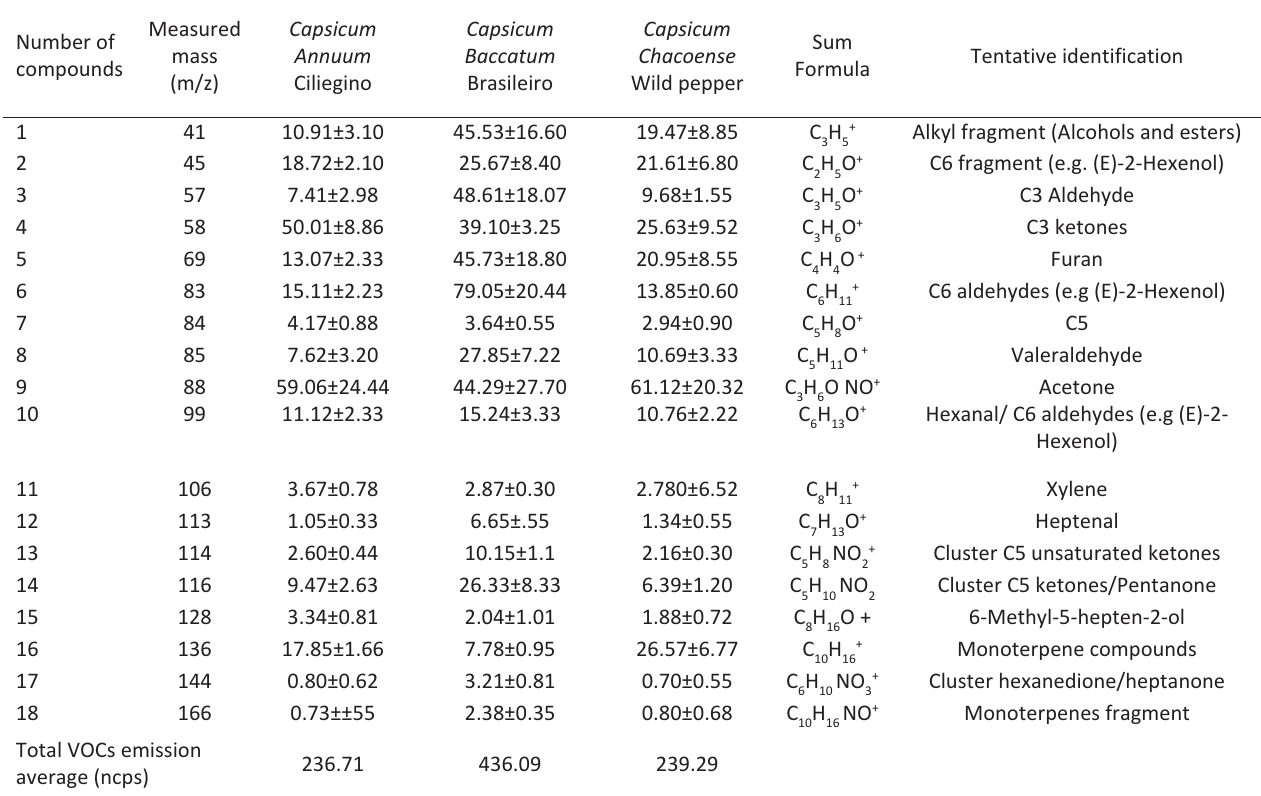
Table 3 ­ SIFT­MS signals obtained using NO+ as reagent ions, in the range between to m/z 20­200. The analysis showed only the signals with intensity expressed in ncps higher than 1 (n=10;